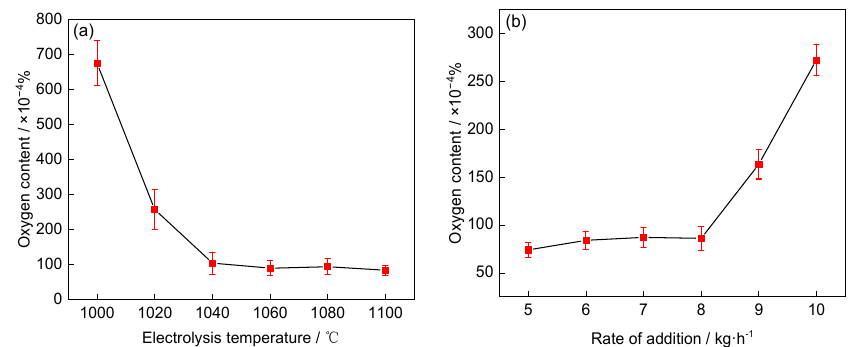
Figure 2. Effect of electrolysis temperature ( a ) and rate of addition ( b ) on oxygen concentration.